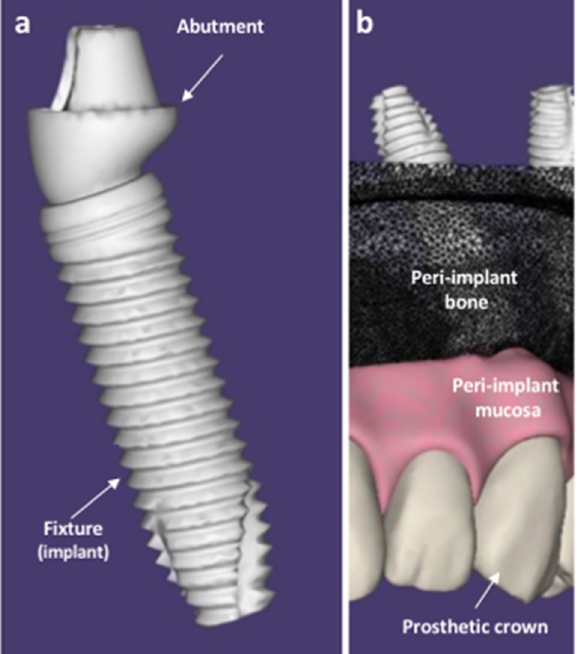
Figure 1. Schematic representation of a dental implant ( a ) and the oral structures (peri-implant mucosa and peri-implant bone) surrounding the fixture ( b ), surgically inserted in the bone. Original figures made by D.M. with SOLIDWORKS ® (CSWP-MBD Version, 2021, SolidWorks, Dassault systems, Waltham, MA, USA).